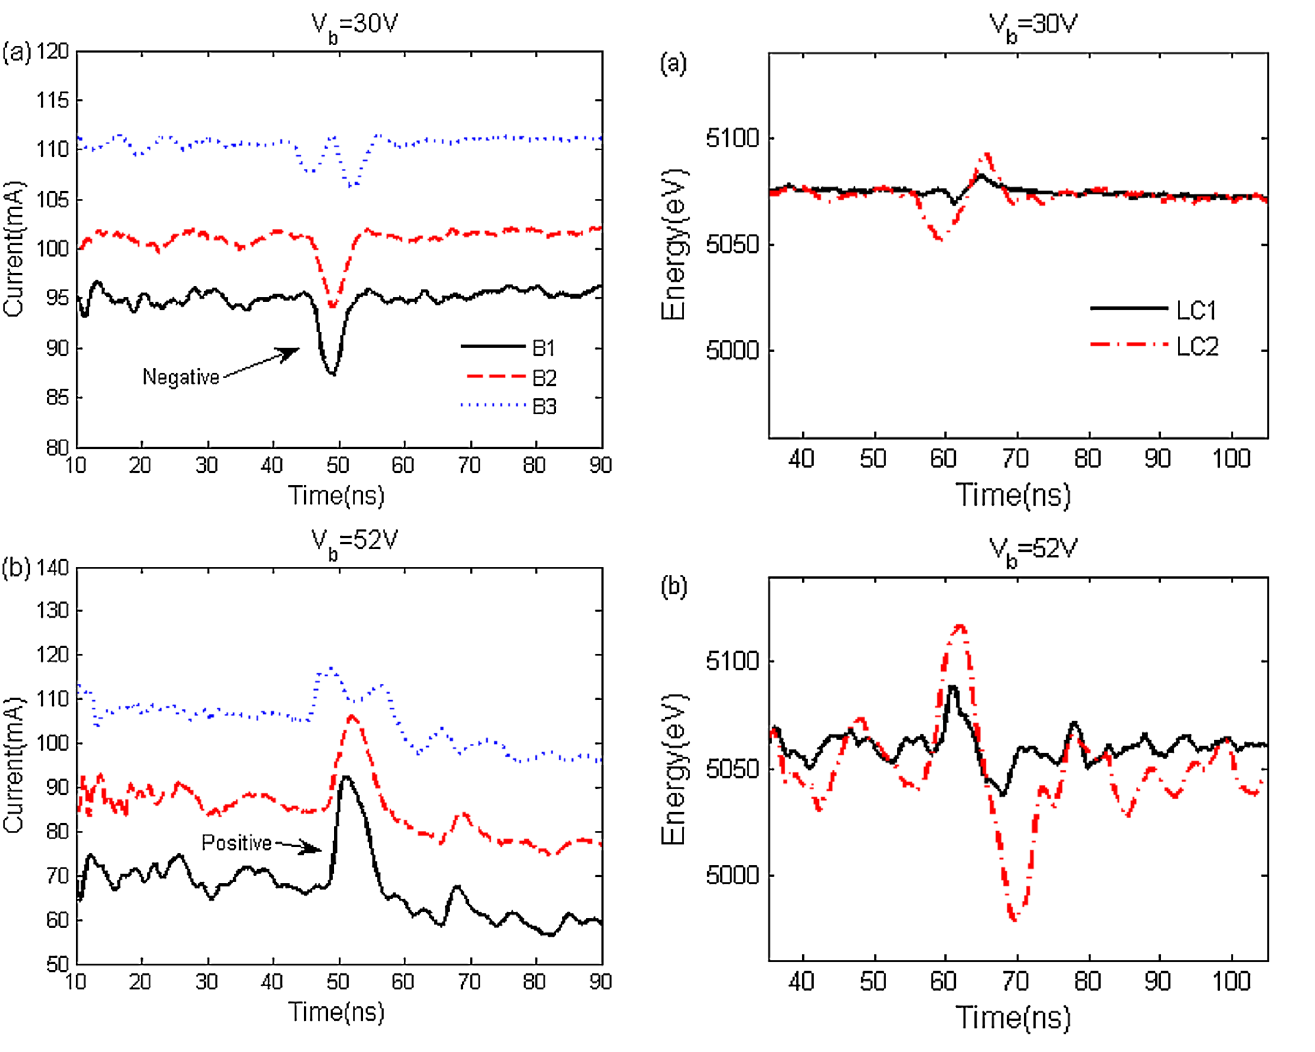
FIG. 4. (Color) Mean energy profiles measured at LC1 (black solid lines) and LC2 (red dashed lines) for 4.9 mm beams with different bias voltages. (a) (cid:3) 1 ¼ 0 : 0026 , (cid:3) 2 ¼ 0 : 0075 ; (b) (cid:3) 1 ¼ 0 : 01 , (cid:3) 2 ¼ 0 : 027 ; where (cid:3) 1 ¼ dE 1 =E 0 , (cid:3) 2 ¼ dE 2 =E 0 , and dE 1 and dE 2 represent peak-to-peak values of the energy perturbations in LC1 and LC2,